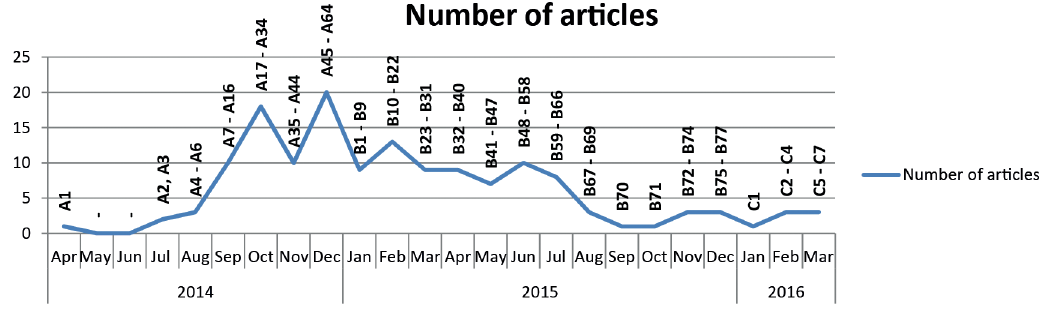
Fig 1. Number of articles published per month between April 2014 and March 2016.